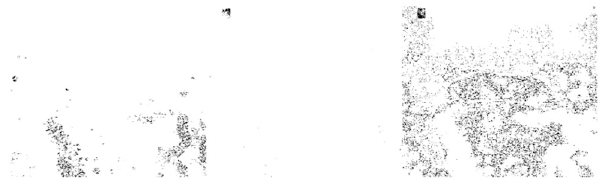
Figure A6. Image results with Binarization process. Test ID: Mrf-2.